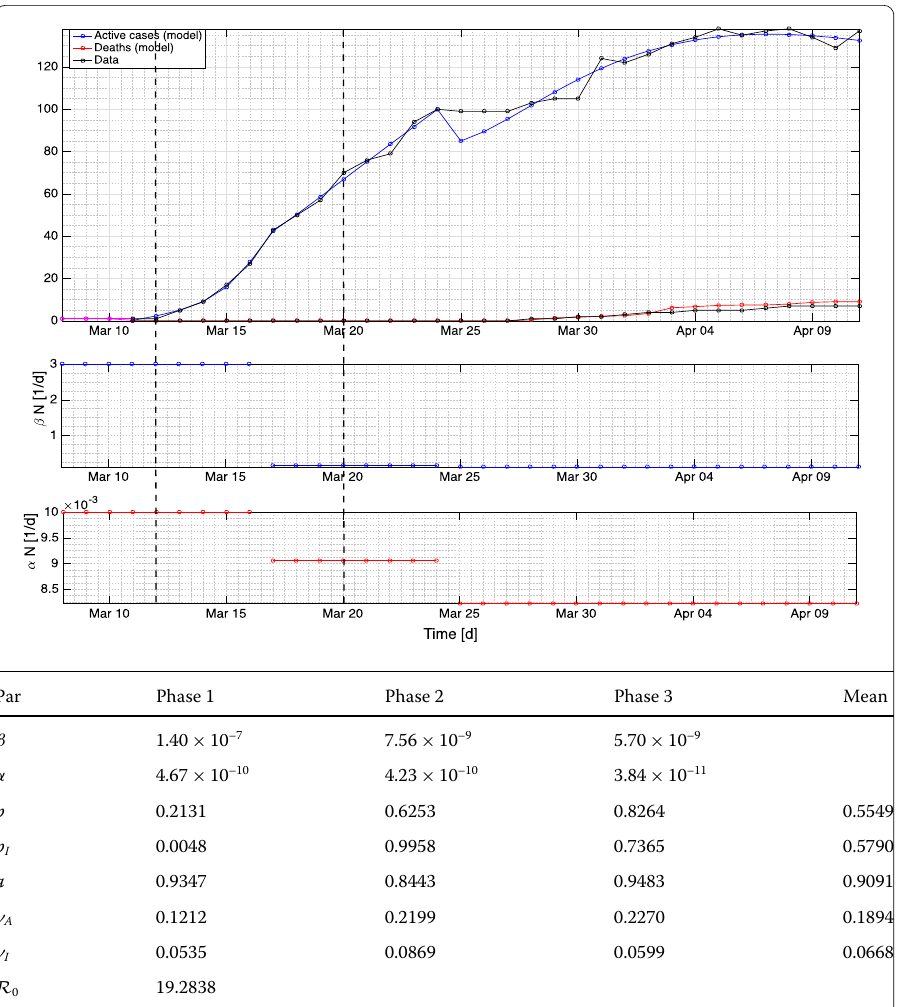
with exact timing of admission and discharge. In case of presence, the objective func- tion should be adjusted by including the hospitalized terms, and a should account for the tradeoff between active and hospitalized cases. Moreover, the findings on recovery rates lead to the hypothesis that the asymptomatic Germans suffer from illness for 5.14d on average, while the symptomatic ones for 18.94d. The asymptomatic and symptomatic Sri Lankans suffer from illness for 5.28d and 14.97d, respectively. Finally, the values of R 0 were computed only on the earlier take-off period. As mentioned in Sect. 3, the different household structures in Germany and Sri Lanka were shown to influence R 0